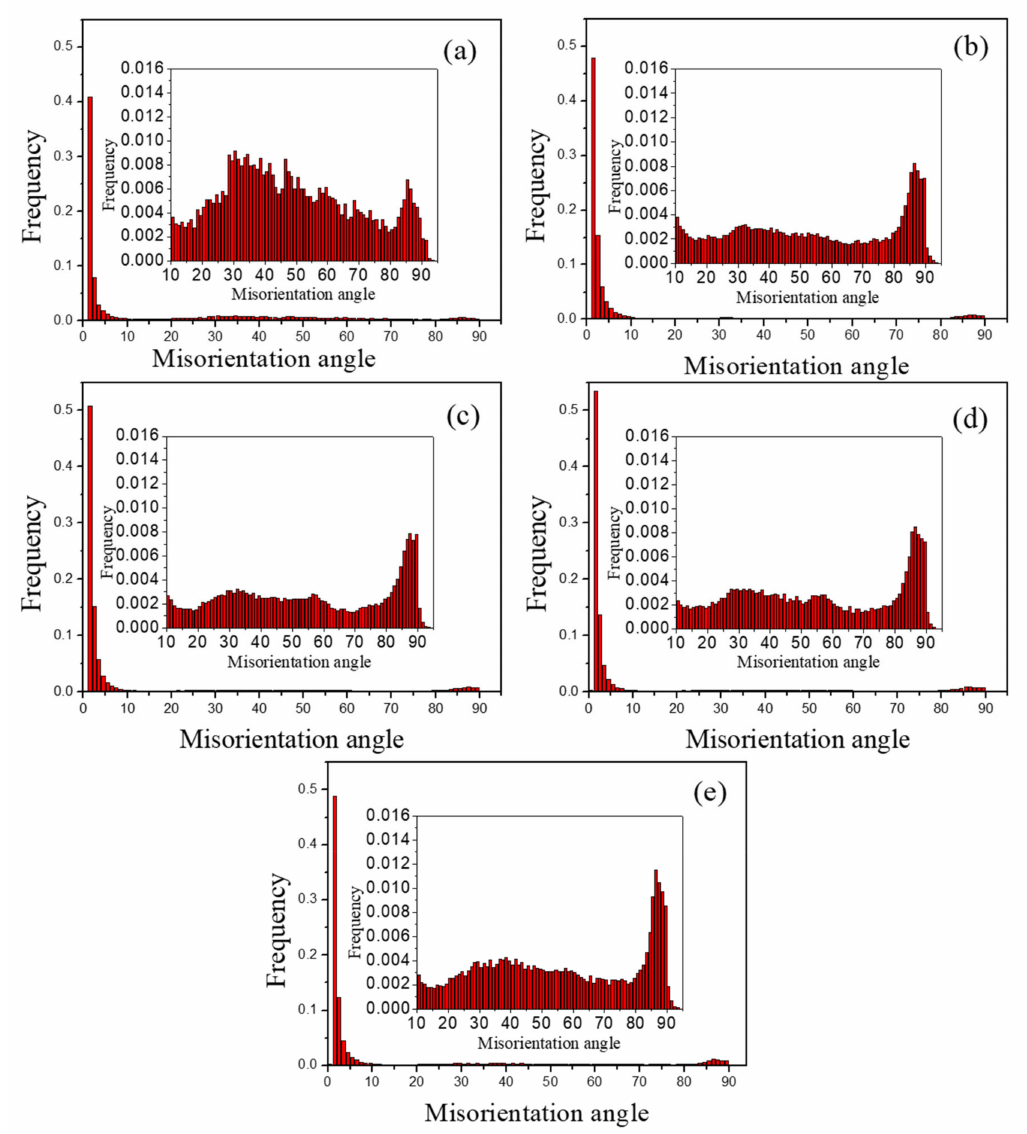
Figure 9. Misorientation distributions in samples obtained in ( a ) as-received Mg-1.9Mn-0.3Ce sheet, and samples loaded at ( b ) 0.001 s − 1 and 293 K, ( c ) 1300 s − 1 and 293 K, ( d ) 1300 s − 1 and 213 K, and ( e ) 1300 s − 1 and 488